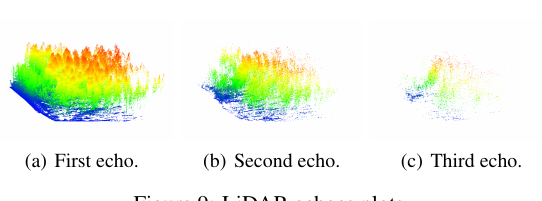
Figure 8: Camera image and LiDAR measurements top view.